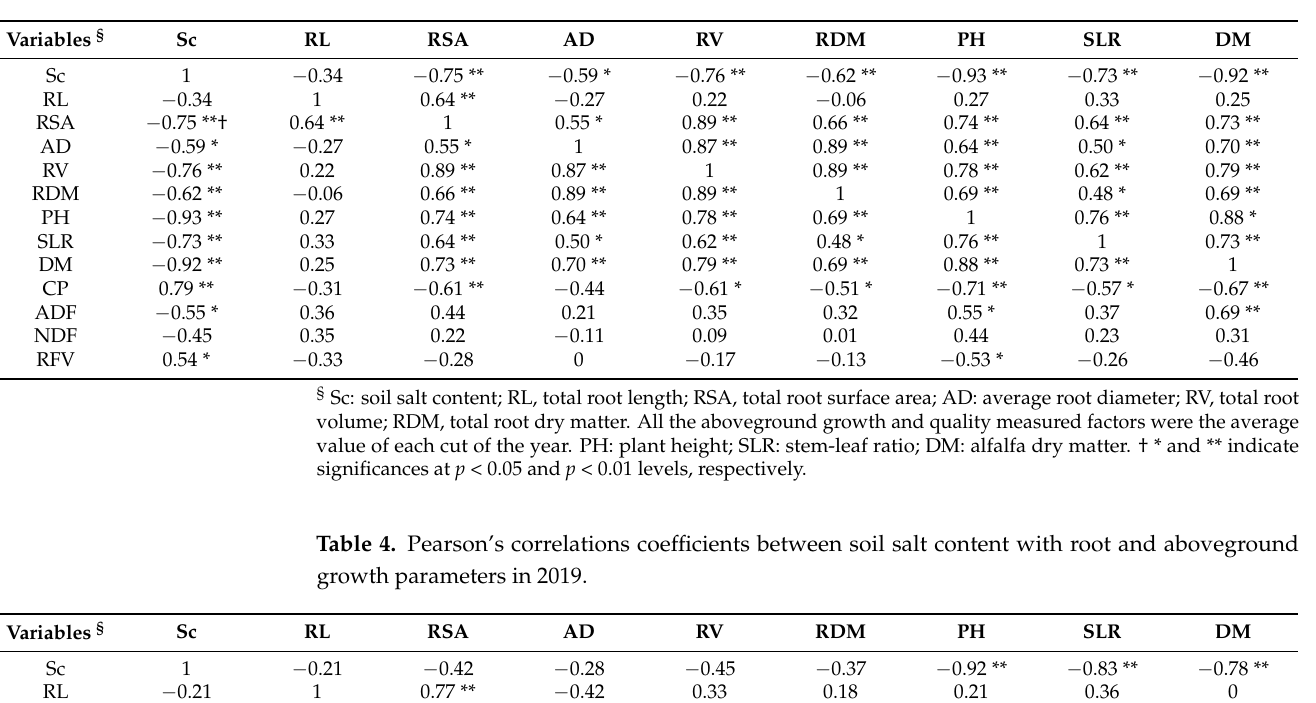
Table 3. Pearson’s correlations coefficients between soil salt content with root and aboveground growth parameters in 2018.